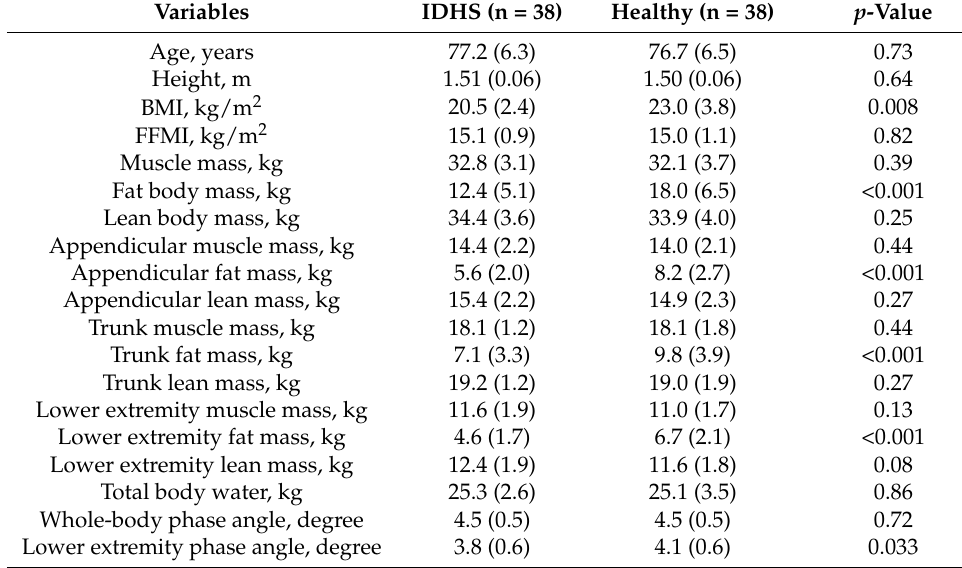
Figure 3. Correlation between BMI and phase angle in both groups. Table 2. Group comparisons using data for PS matching.